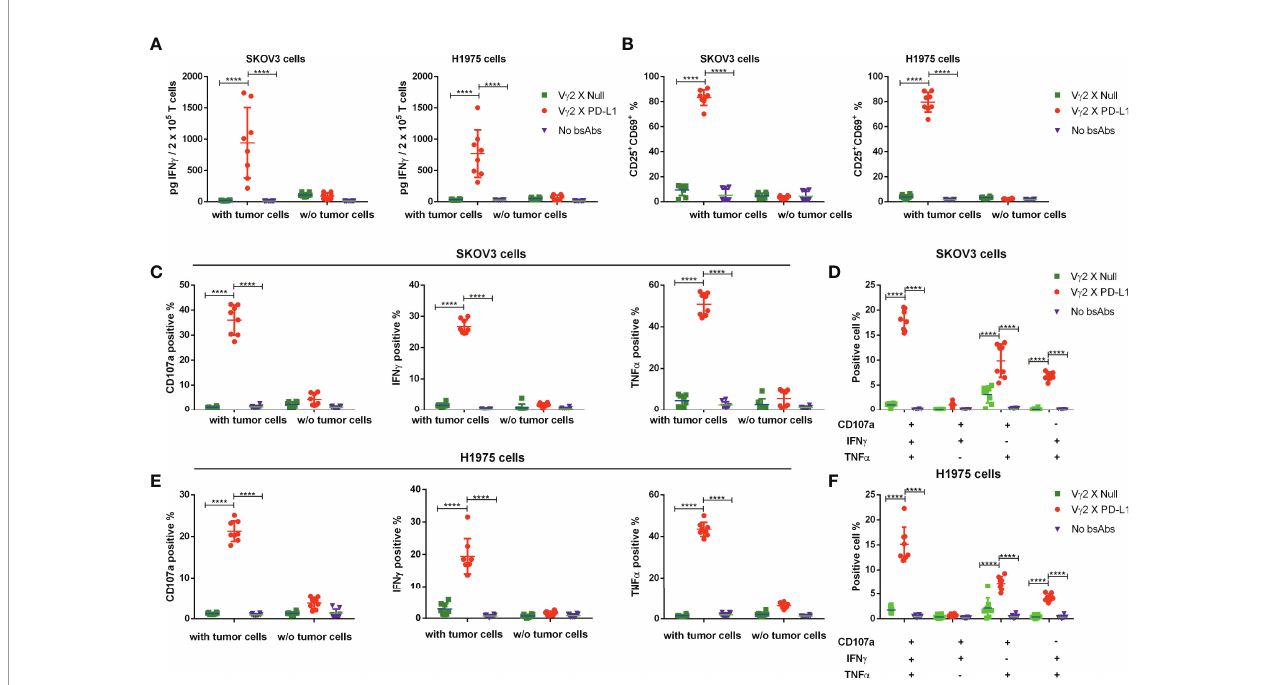
FIGURE 3 | V g 2 x PD-L1 revoked speci fi cally activation, of the expanded V g 2V d 2 T cells in the presence of PD-L1 + tumor cell lines. (A) V g 2 x PD-L1 increased signi fi cantly the IFN g secretion and (B) prompted activation of the expanded V g 2V d 2 T cells in a PD-L1-dependent fashion. V g 2V d 2 T cells were co-cultured with indicated tumor cell lines (SKOV3 or H1975) in the absence or presence of V g 2 x PD-L1 or V g 2 x Null (1 m g/mL of each, about 8 nM) at a ratio of 1:1 for 24 hours. Then the supernatant was harvested for measuring the concentration of IFN g by ELISA (A) , and cells were collected for staining CD25+CD69+ double-positive populations (B) . (C – F) V g 2 x PD-L1 activated speci fi cally V g 2V d 2 T cells to produce IFN g and TNF a , and degranulate in the presence of PD-L1 + tumor cell lines. V g 2V d 2 T cells were stimulated by V g 2 x PD-L1 or V g 2 x Null (1 m g/mLof each) in the presence/absence of H1975 (C, D) or SKOV3 (E, F) cells in a 1:1 ratio for 4 hours. The percentages of T cells positive for CD107a, TNF a , and IFN g measured by ICS were represented in (C, E) and the percentages of multi-functional effector subsets of V g 2V d 2 T cells were shown in (D, F) Data were presented as Mean ± SD pooled from n=8 biological replicates of three independent experiments. **** p < 0.0001 (Two-way ANOVA, Tukey ’ s multiple comparisons test for (A, B, C, E) Dunnett ’ s multiple comparisons test for (D, F)